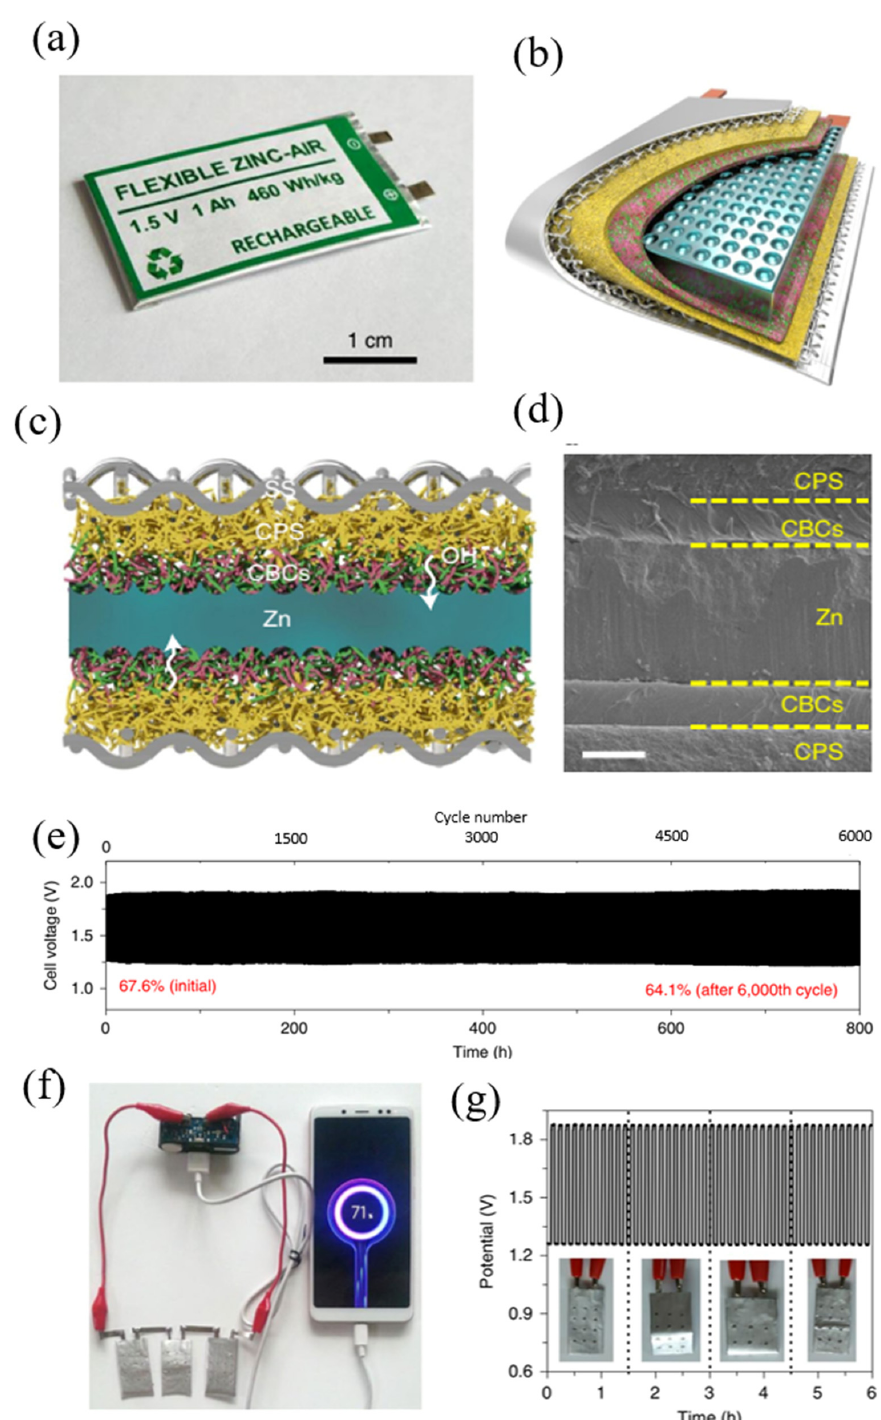
Figure 16. ( a ) A photo-picture of zinc–air pouch cell. ( b ), graphic scheme dissecting a layered construction of the pouch cell, ( c , d ) a cross-sectional representation, ( c ) exhibiting the uniformly ordered cross arrangement with [CPS(101)||CBCs||patterned zinc||CBCs||CPS(101)] and ( d ) the related cross-sectional SEM micrograph, ( e ) cyclization of CPS(101)||CBCs||patterned zinc||CBCs||CPS(101) at current density of 25 mA/cm 2 . The percentile values display the potential effectiveness of the cells. ( f ) Display 3 pouch cells charging a smartphone (threshold voltage of 4.5 V) and ( g ) Charge/discharge cyclic performance under distinct bending angles (0 ◦ , 90 ◦ , 180 ◦ (folding) and 0 ◦ ) at 25 mA/cm 2 [83]. Reprinted with permission from Ref. [83], Copyright 2021, Springer